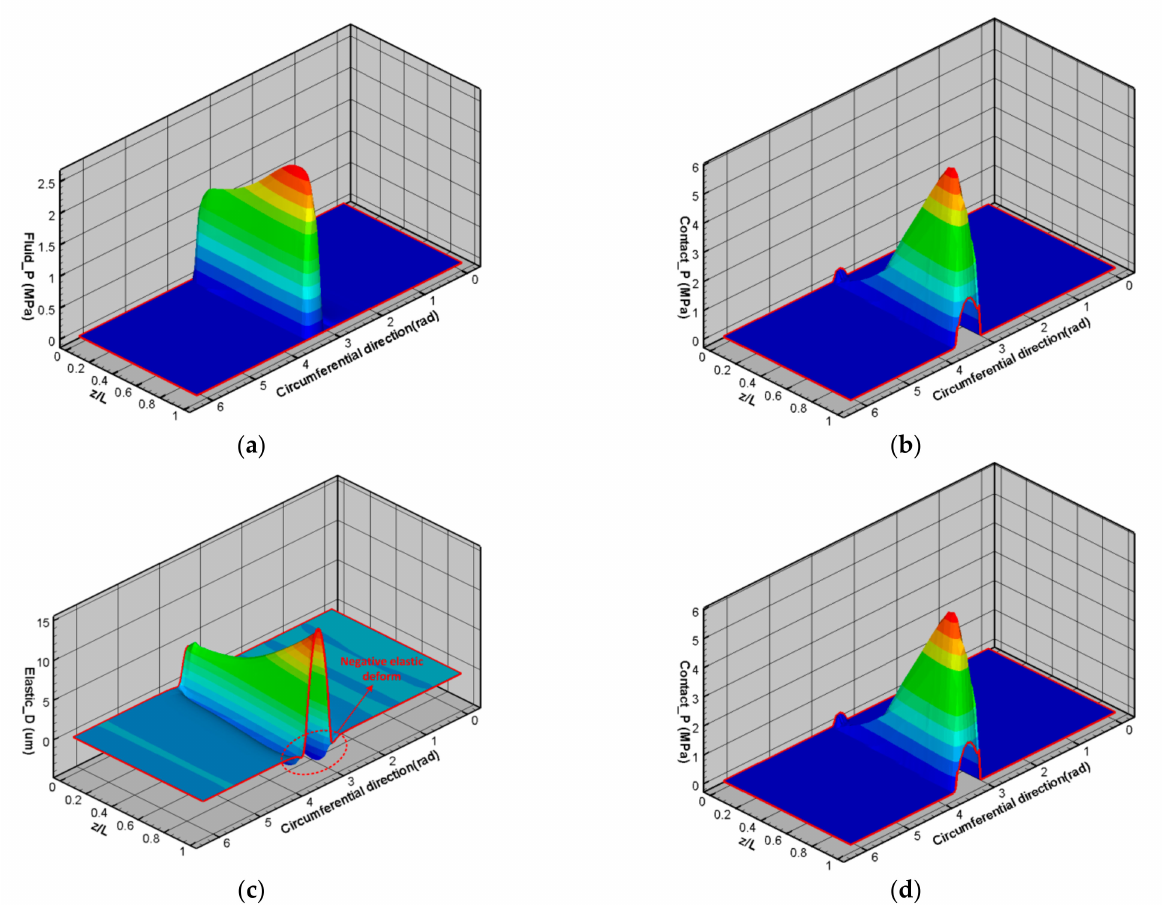
Figure 10. Distribution of deformations and pressure when deflection of the propeller shaft is considered: ( a ) water film pressure; ( b ) contact pressure; ( c ) elastic deformation; ( d ) thermal